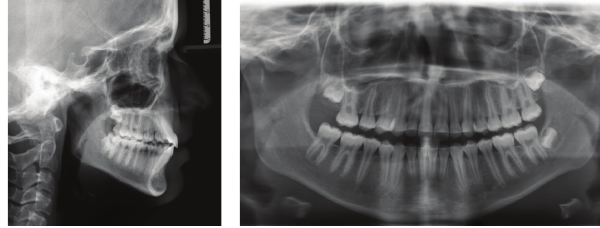
Figure 7: Posttreatment